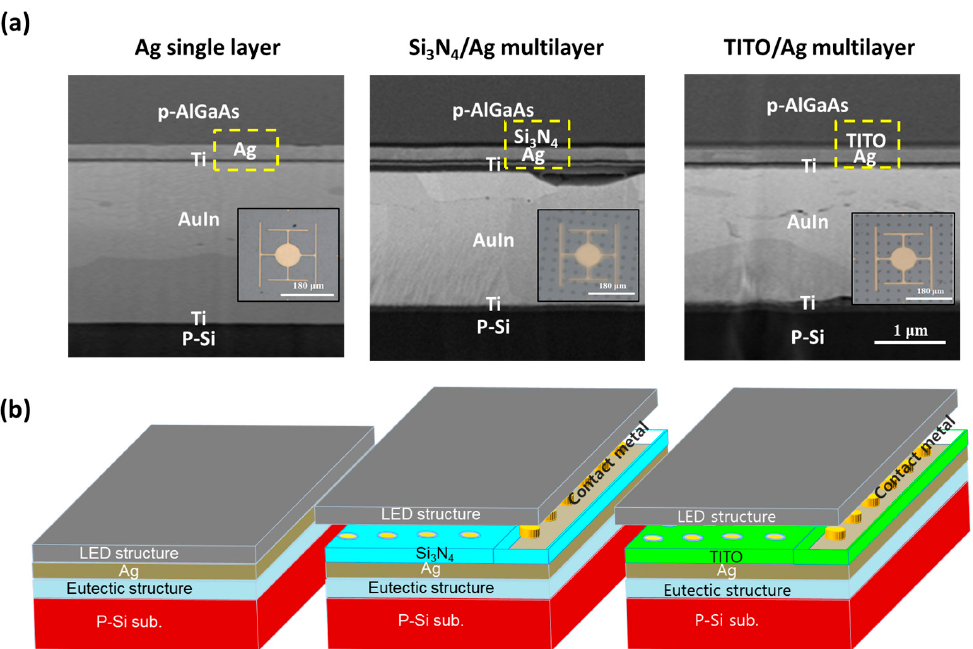
Figure 3. NIR-LED chips with Ag single, Si 3 N 4 /Ag and TITO/Ag multilayer reflectors; ( a ) cross-sectional SEM images and ( b ) structural schematics.